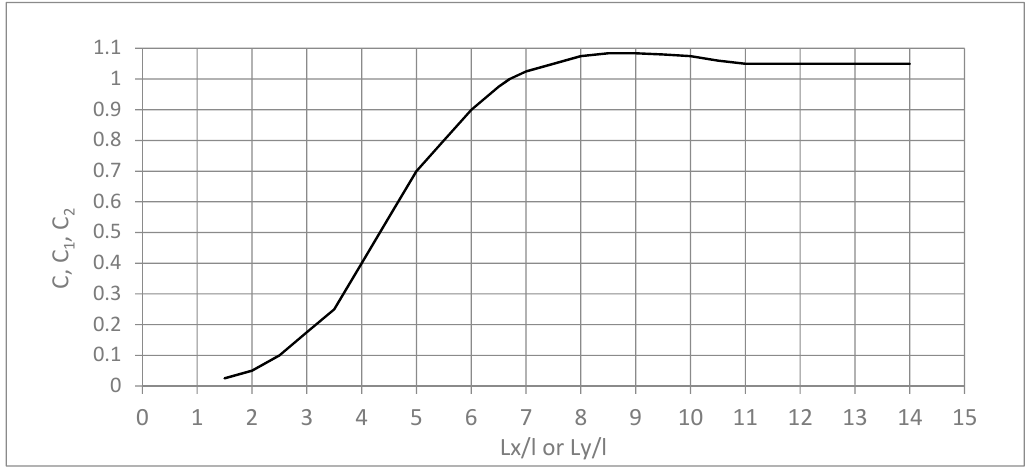
Figure 5. Bradbury’s warping stress coefficients.